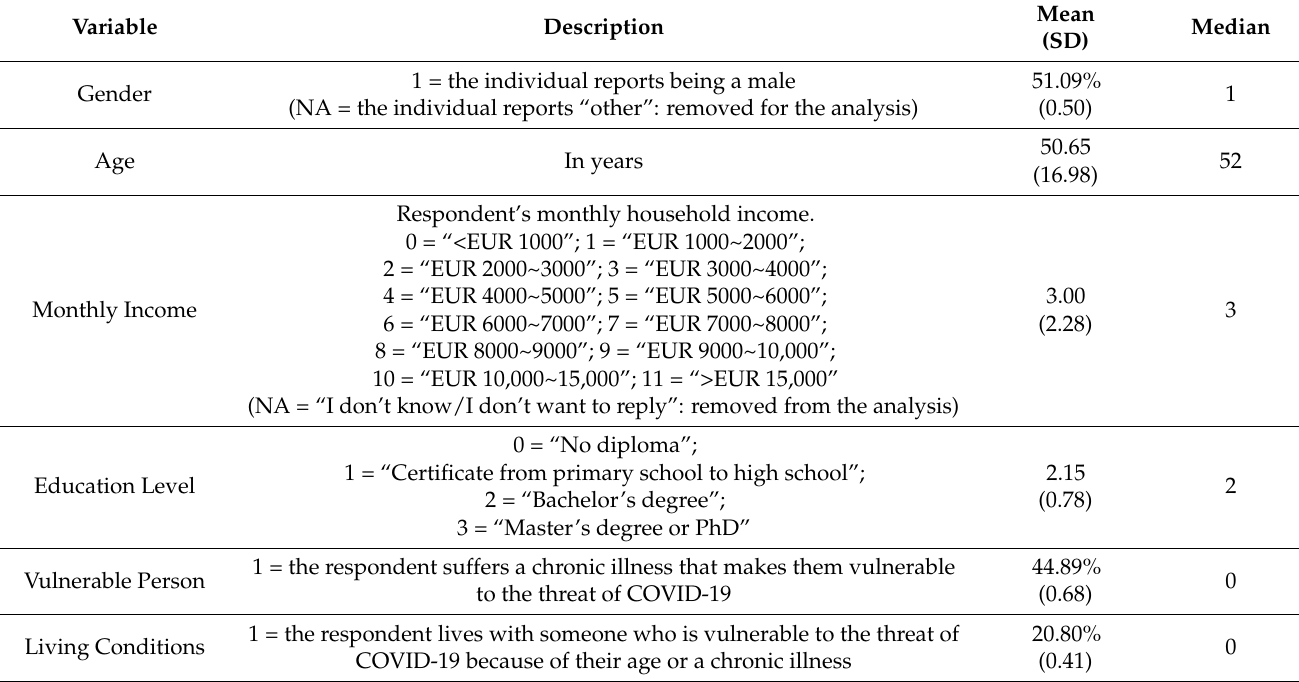
Table 2. Definitions and descriptive statistics of the control